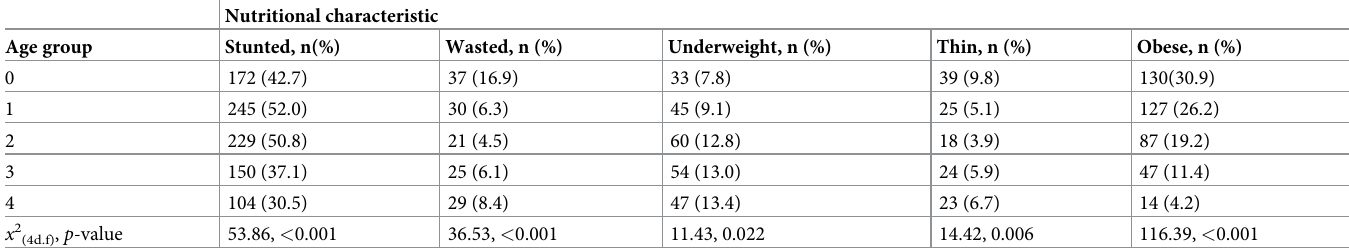
Table 3. Nutritional characteristics of the study population in relation to age groups. Nutritional